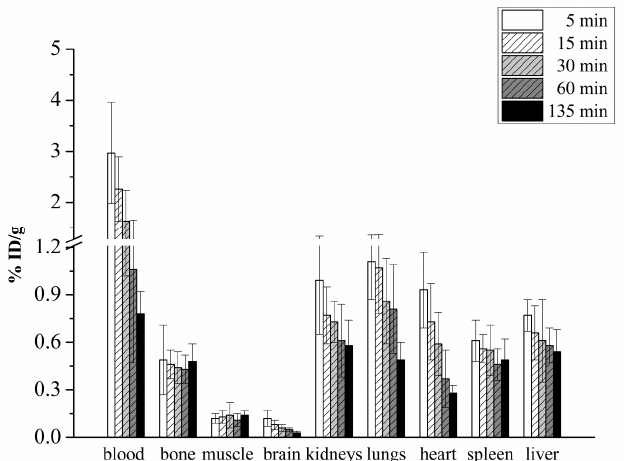
Figure 5. Biodistribution data of [ 68 Ga]Ga ‐ THP ‐ NH(CH 2 ) 9 Tac in rats after different time p.i.